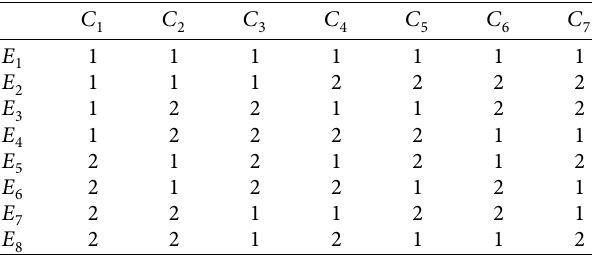
( 2 7 ) with the canonical 8